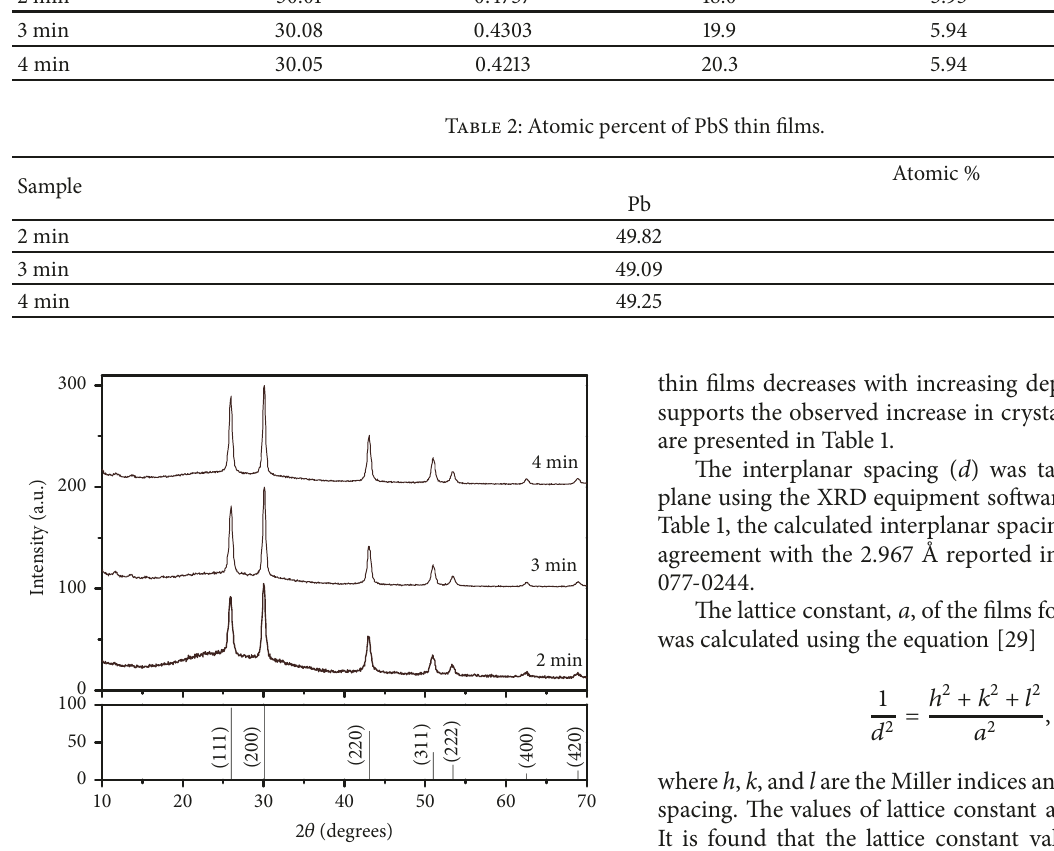
Figure 1: XRD patterns of PbS thin film as a function of deposition